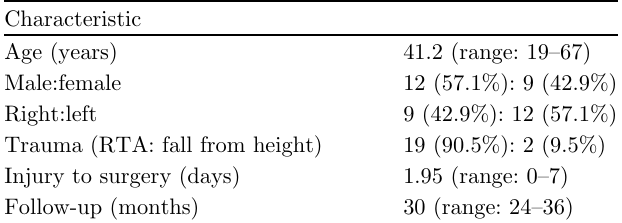
Table 1. Patients characteristics. Characteristic